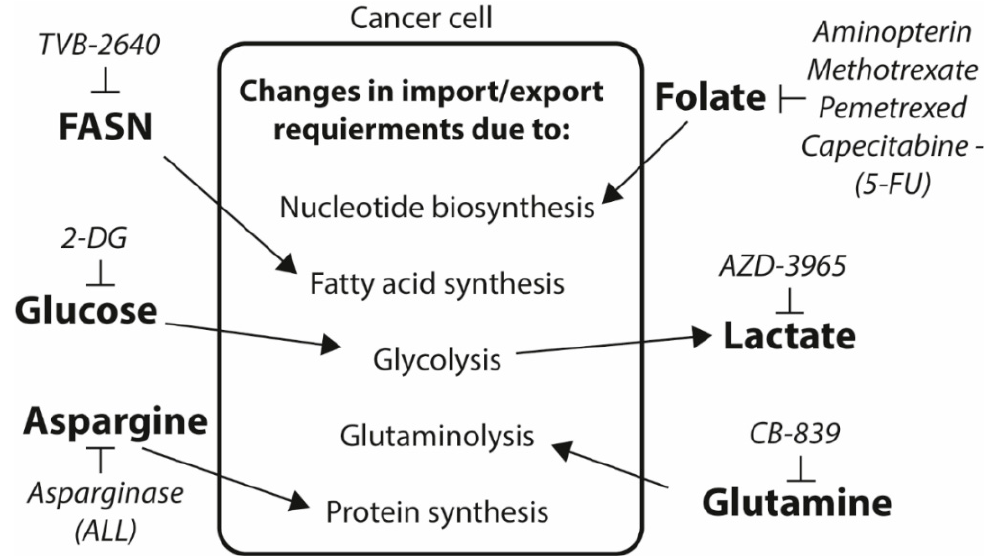
Figure 2. Schematic illustration of how drugs or drug targets are involved in cancer metabolic pathways. Table 1. Approved drugs targeting specific metabolic aspects of the cancer metabolism.